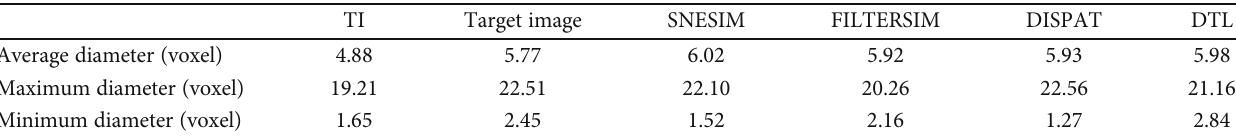
Table 6: The average pore diameters (shale) in the TI, the target image, and the reconstructed images of SNESIM, FILTERSIM, DISPAT, and DTL.